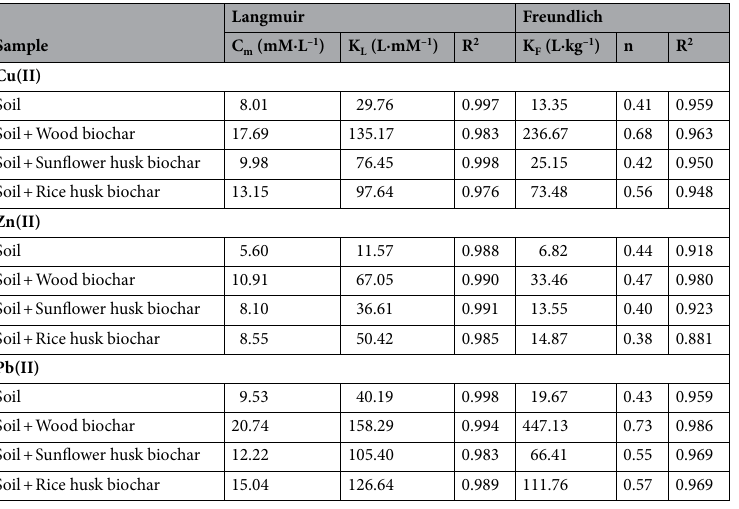
Table 3. Fitted parameters for adsorption isotherms of HM by soil in pure form and with different biochars in single-metal